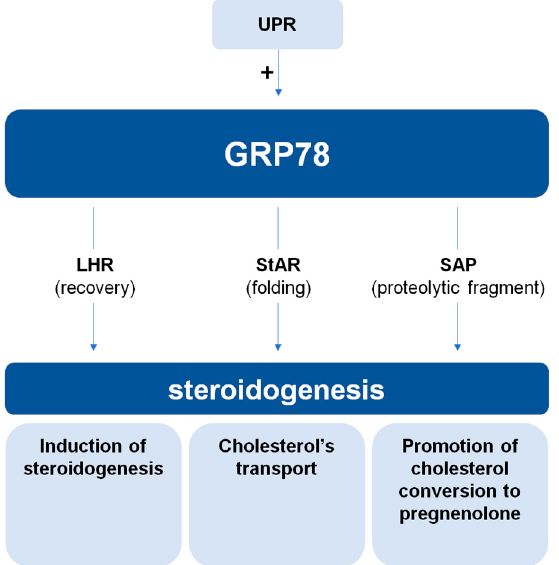
Figure 2. Schematic model of currently established interactions of GRP78 with steroidogenesis through three different pathways. In a preliminary scenario GRP78 promote the recovery of LHR and therefore initiates steroidogenesis and progesterone production. GRP78’s interaction with StAR ensures proper protein folding and subsequent activation of cholesterol transport. Furthermore, via the production of steroidogenesis-activator polypeptide (SAP), the conversion of cholesterol to pregnenolone is promoted. Meanwhile, an impact of the unfolded protein response (UPR) through the indirect role of GRP78 on steroidogenesis is implied. (“+”: activation).